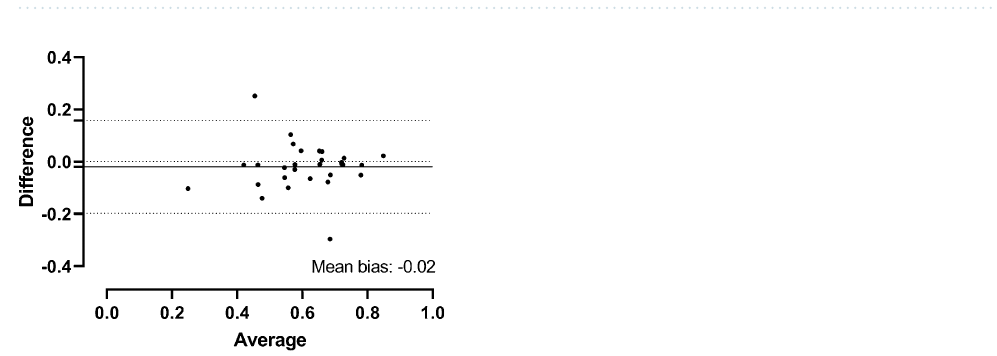
Figure 5. Linear regression analysis of the T1 reduction rates at 1.5 T and 3 T. This figure shows the linear regression analyses of intra-patient T1 reduction rates of 29 patients, who had MRI examinations at both 1.5 T and 3 T within 180 days apart. Without constraint, the regression formula was y = 0.78 * x + 0.15 with R 2 = 0.61 and p < 0.001 ( A ). If the regression line was forced to go through the origin (0/0), the regression formula was y = 1.02 * x + 0.00 with R 2 = 0.54 and p = 0.029 ( B ).